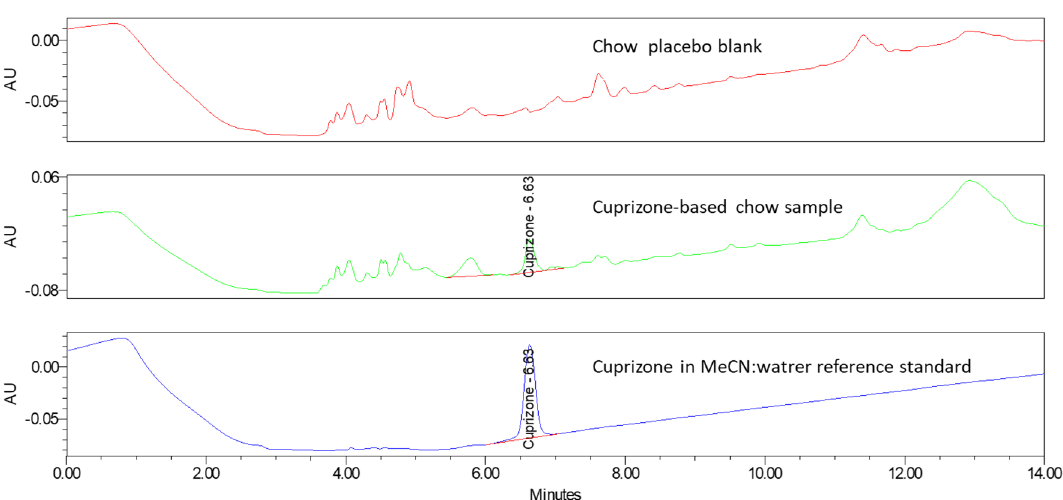
Figure 7. HPLC chromatogram of cuprizone samples in Xbridge HILIC